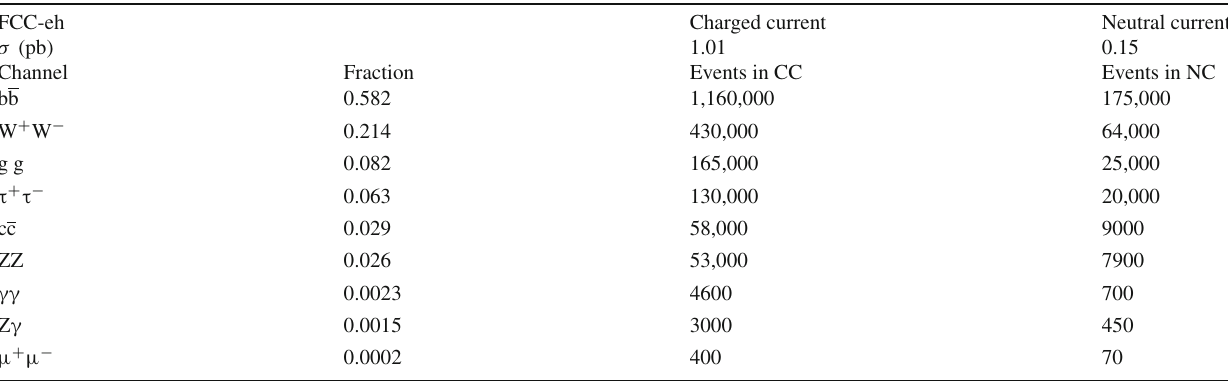
Fig. 4.10 Same as Fig. 4.6, for the HE-LHC Table 4.6 Event rates for SM Higgs decays in the charged (ep → ν HX) and neutral (ep → eHX) current production mode at FCC-eh, with 2ab − 1 and assuming a P = − 0 . 8 electron polarisation. The top seven channels are used in the subsequent signal-strength and coupling